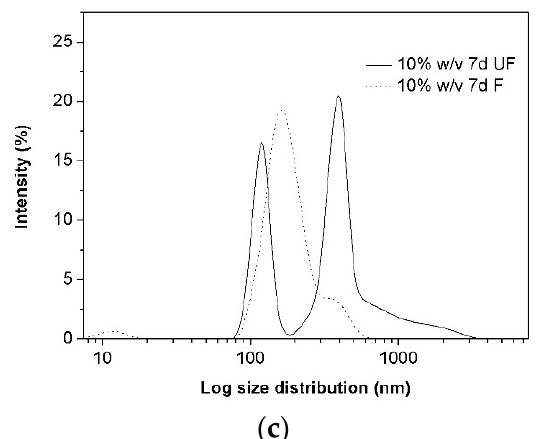
Figure 5. ( a ) Intensity fraction size distributions of the apparent hydrodynamic radius of HPβCD aggregates in pure aqueous HPβCD solutions, as measured by DLS at 23 °C. ( b ) Particle size distribution of HPβCD aggregates in freshly prepared aqueous solutions and after equilibrium of the sample solutions for seven days at room temperature (about 23 °C) ( c ).